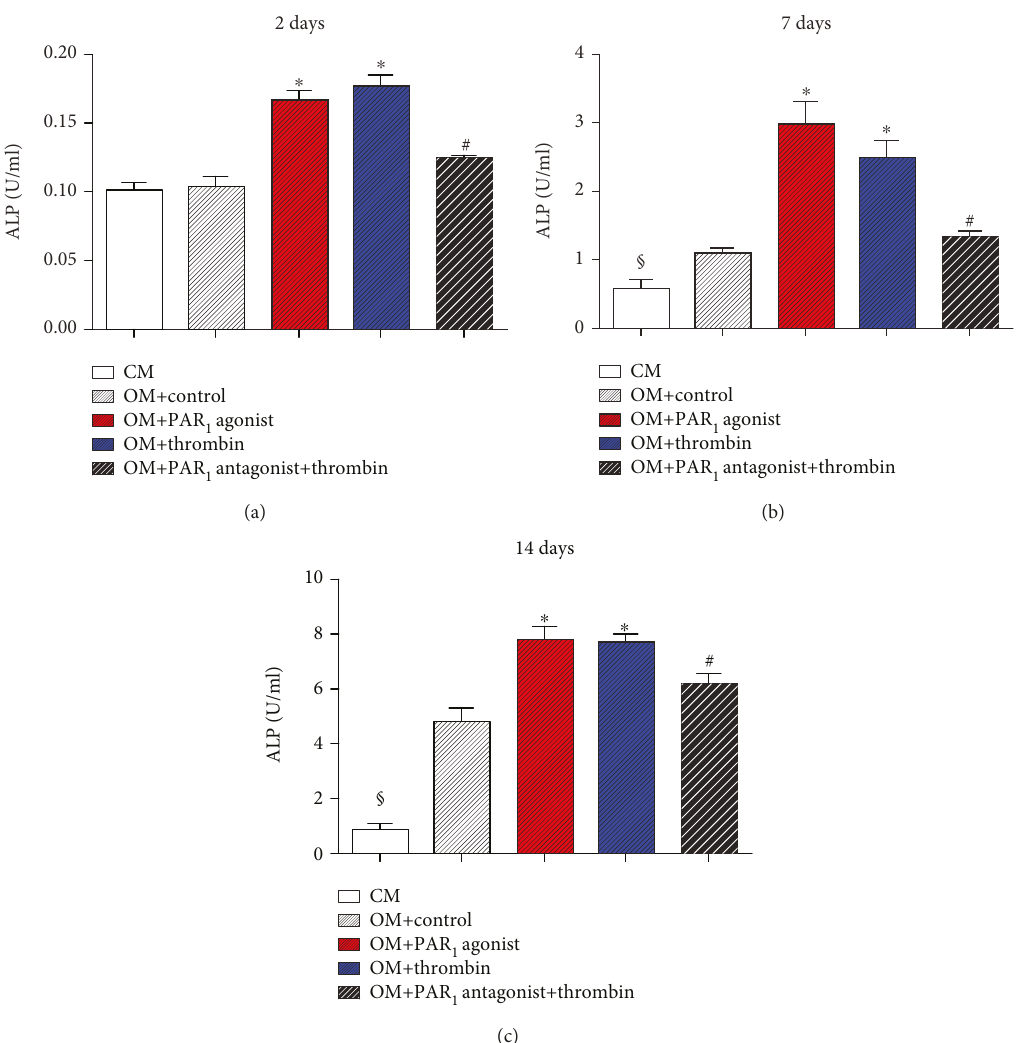
Figure 3: ALP activity in di ff erent groups. Values are presented as mean and SEM; n = 3 . ∗ Mean signi fi cant di ff erence when compared to OM + control ( p < 0 05 ). # Mean signi fi cant di ff erence when compared to OM + thrombin ( p < 0 05 ). § Mean signi fi cant di ff erence when compared to OM groups ( p < 0 05